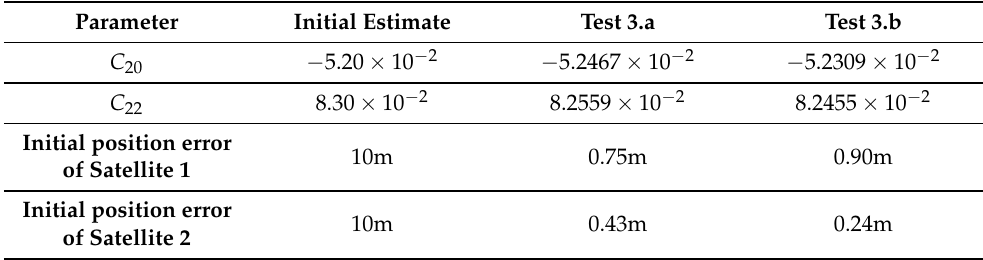
Figure 6. Residual in the observation data ( left ) and norm of the position error of the determined orbit from the true one ( right ) (test 3 with small errors in the initial estimate). Table 3. Recovery result of test 3.